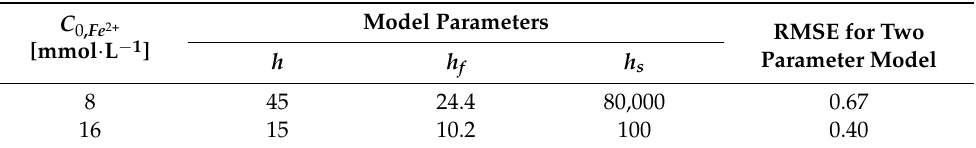
Table 2. Modeling results of the ferrous oxalate precipitation behavior for two initial concentrations of ferrous ions ( C ) of 8 and 16 mmol · L − 1 by using the ferrous ammonium sulfate system at 0,Fe 2 + C OA = 60 mmol · L − 1 and 25 ◦